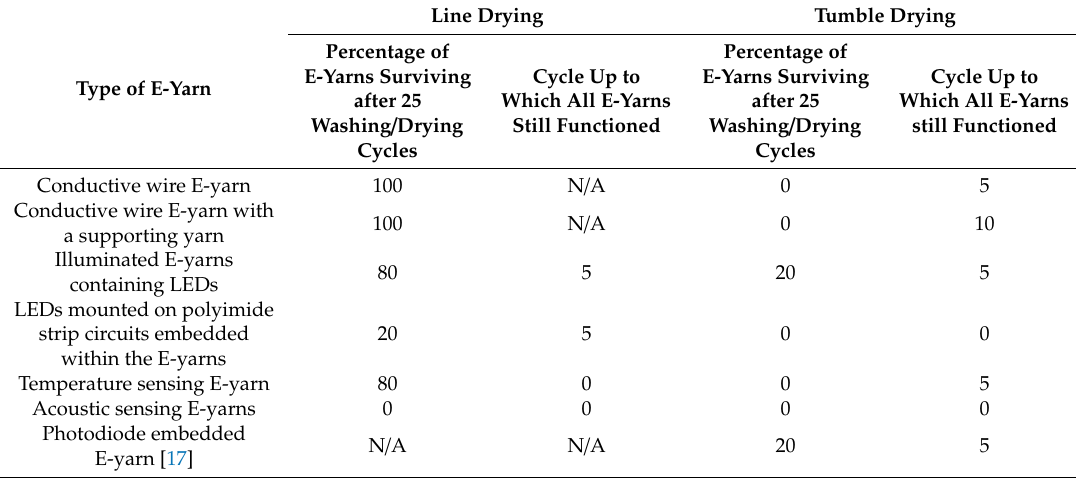
Table 2. Summary of key E-yarn wash test